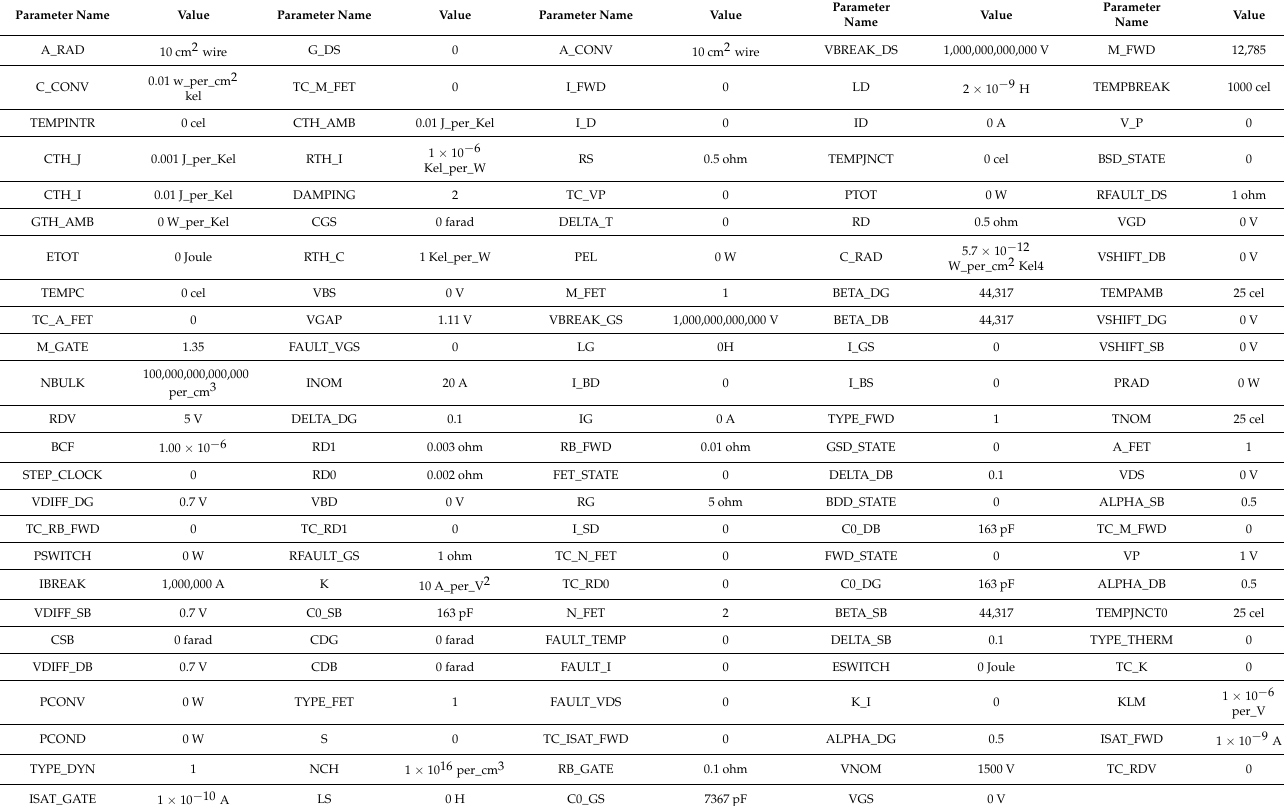
Table A1. Electrical parameters of the NMOS transistors Q1A(B) and Q4A(B) from Figure 6.